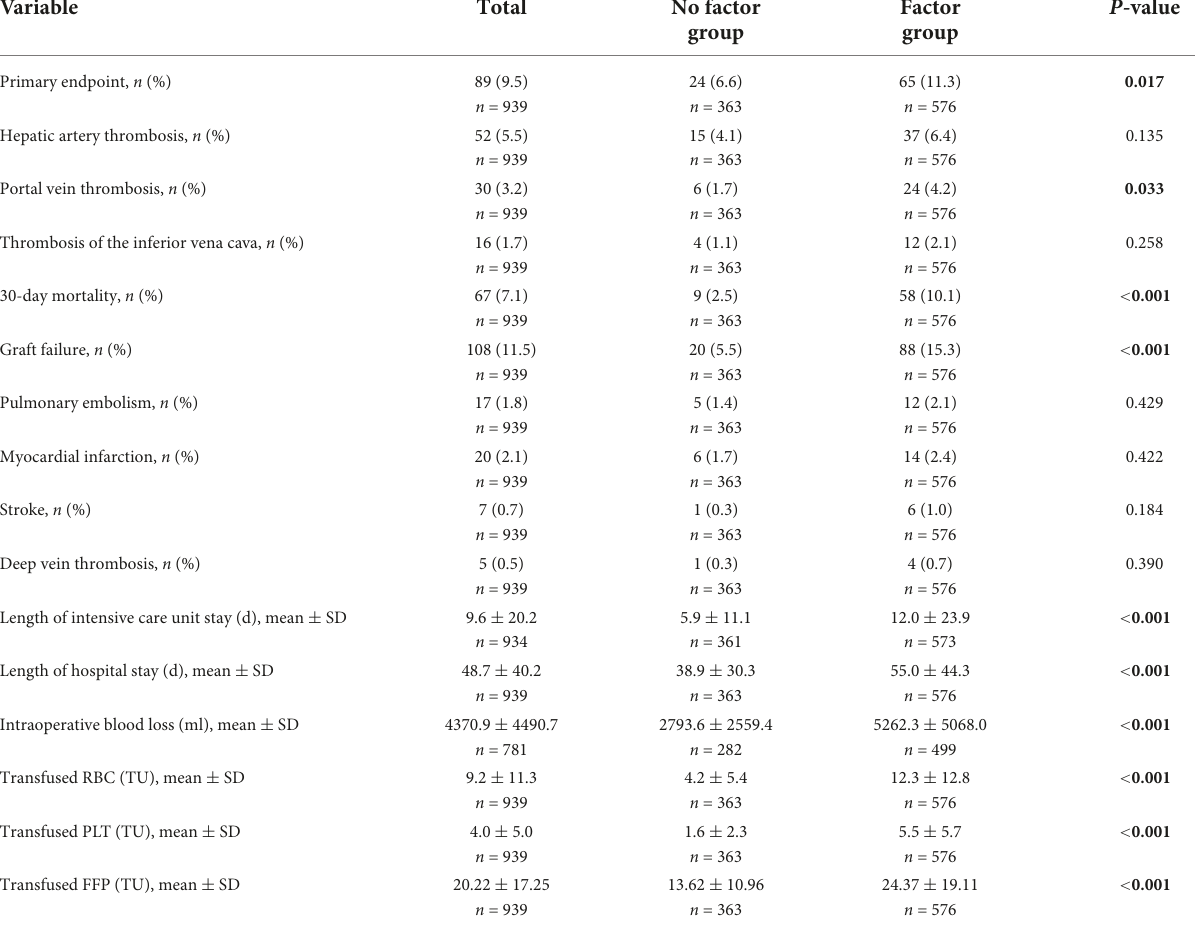
TABLE 2 Outcome analysis.